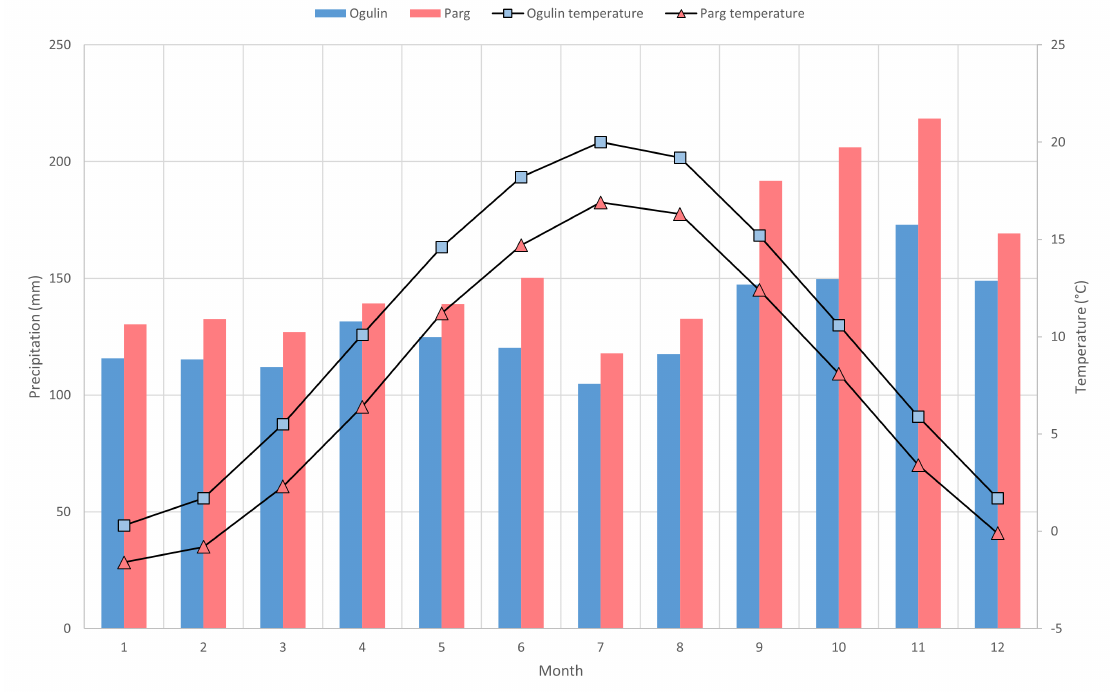
Figure 3. Monthly mean precipitation and monthly mean temperature at meteorological stations Parg and Ogulin in the period